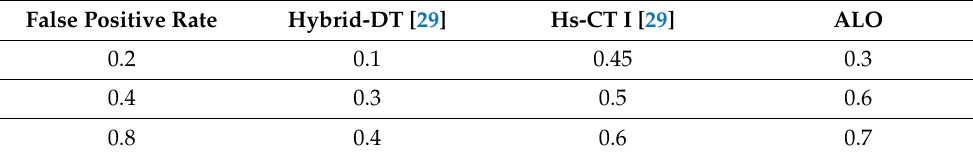
Table 1. Analysis of False positive rate of different techniques.